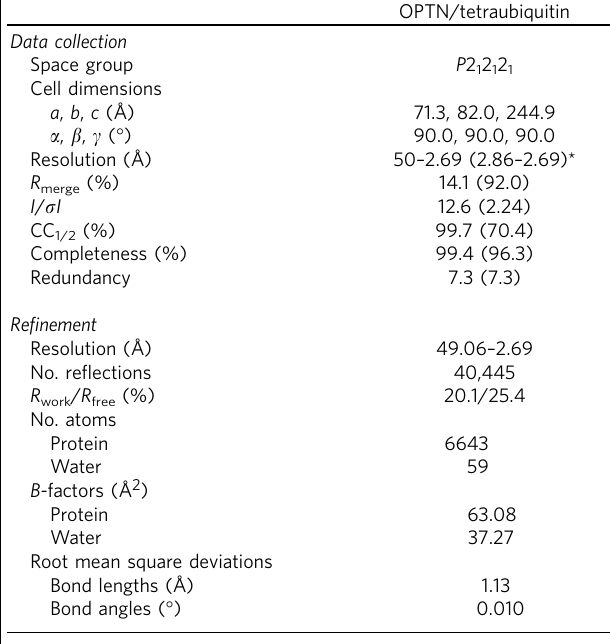
Table 1 | Data collection and refinement